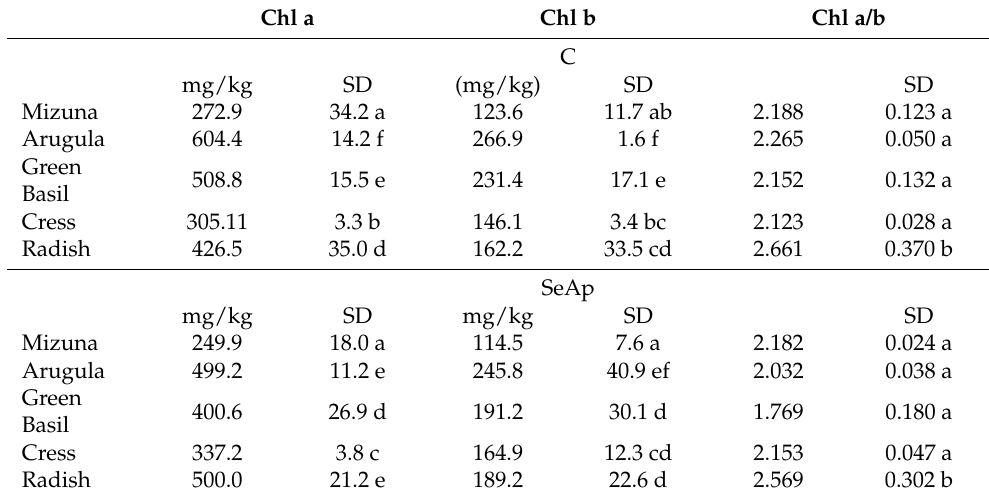
Table 4. Chlorophyll content in microgreens species after fortification with sodium selenate.